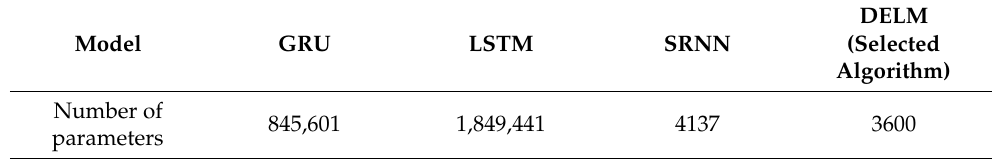
Table 4. Number of parameters of different methods.